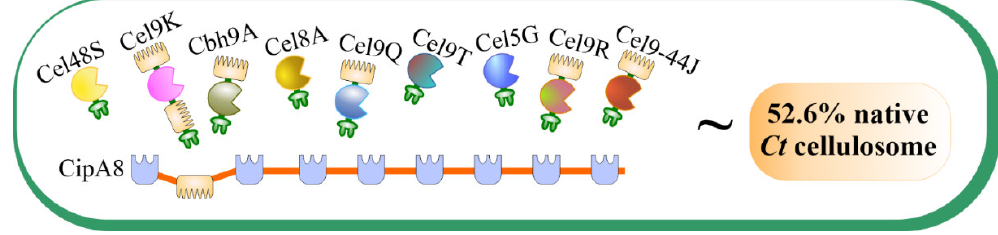
Figure 1. Full synthetic cellulosome complex containing 25% of Cel48S, 12.5% each of Cel9K, Cbh9A, Cel8A, Cel9Q, Cel9T, and 4.2% each of Cel5G, Cel9R, and Cel9-44J (stoichiometric assembly ratio, % mol), whereas the stoichiometric binding capacity equals 1:8 (CipA:single enzyme). Abbreviations in the Figure 1: Ct , C. thermocellum